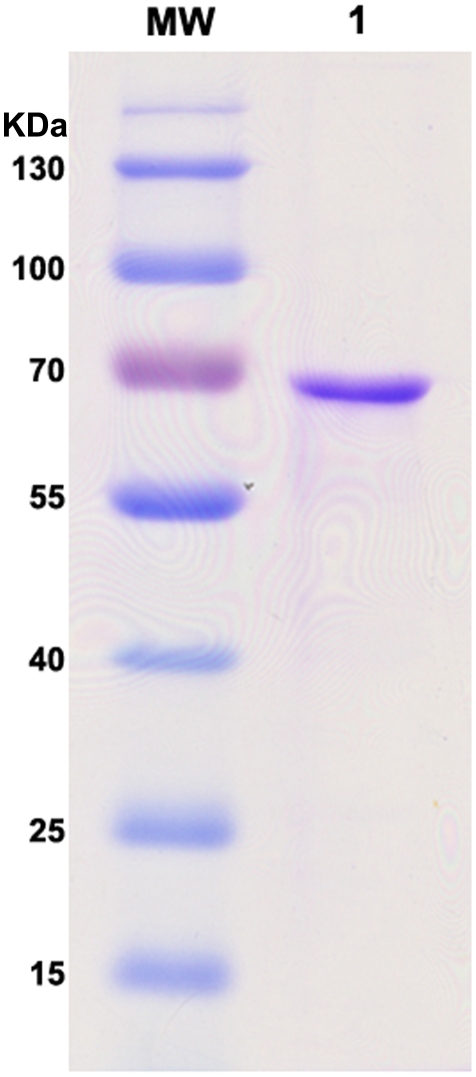
Protein profile of purified recombinant SjTGR.Lane 1: Purified recombinant SjTGR protein on SDS-PAGE gel stained with Commassie Blue. MW: Protein molecular weight marker.